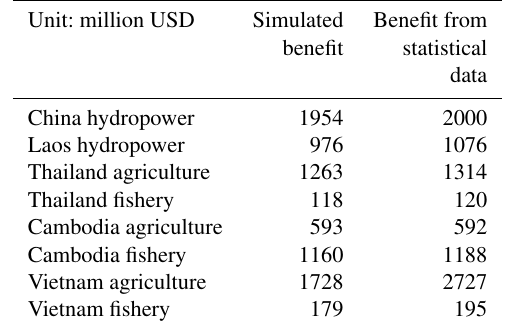
Figure 7. Water release of Xiaowan, Nuozhadu and virtual Laos reservoir in non-flood seasons in 2015 (dry year) and 2017 (normal year) under different scenarios. Table 4. Simulated economic benefits in 2018 and statistical bene-